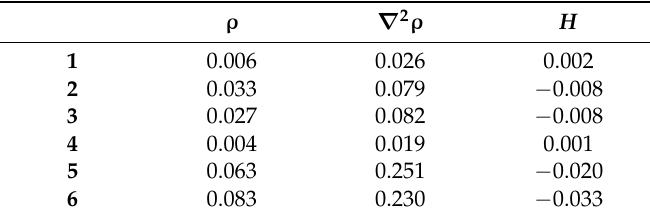
Figure 3. AIM diagrams before and after tetracyano substitution of 6-OTF 3 -fulvene ··· NH 3 (T = C and Si). The units of distance and E int are Å and kJ/mol, respectively. Table 2. Electron density ( ρ , a.u.), Laplacian ( ∇ 2 ρ , a.u.), and total energy density (H, a.u.) at the intermolecular BCP.